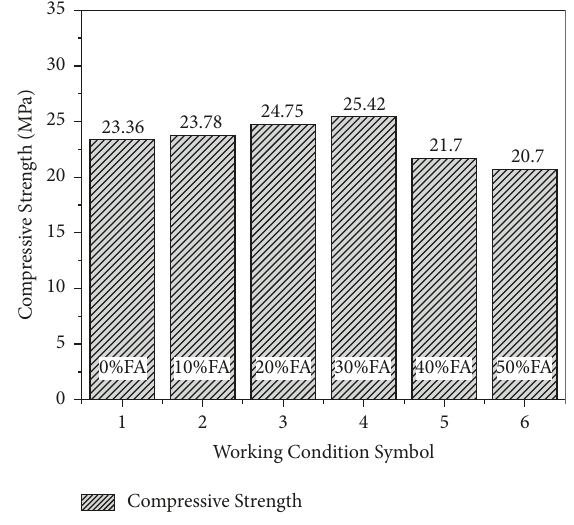
Figure 4: Compressive